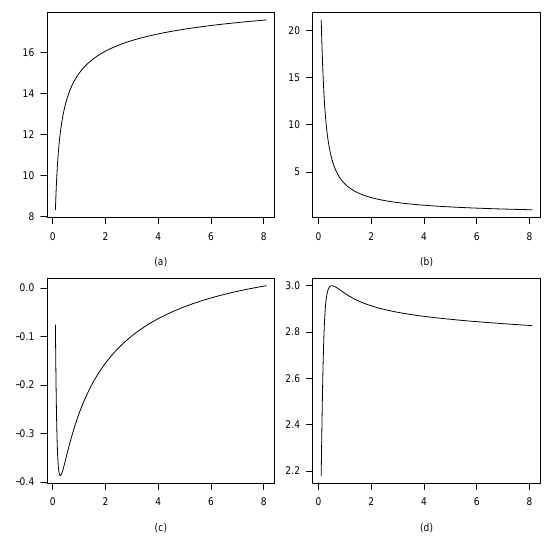
Figure 4 – Mean, in panel (a), variance, in panel (b), skewness, in panel (c), kurtosis, in panel (d), ( θ , α ) } , for m = 20, θ = 0.75, and α > of the power binomial distributions { r i